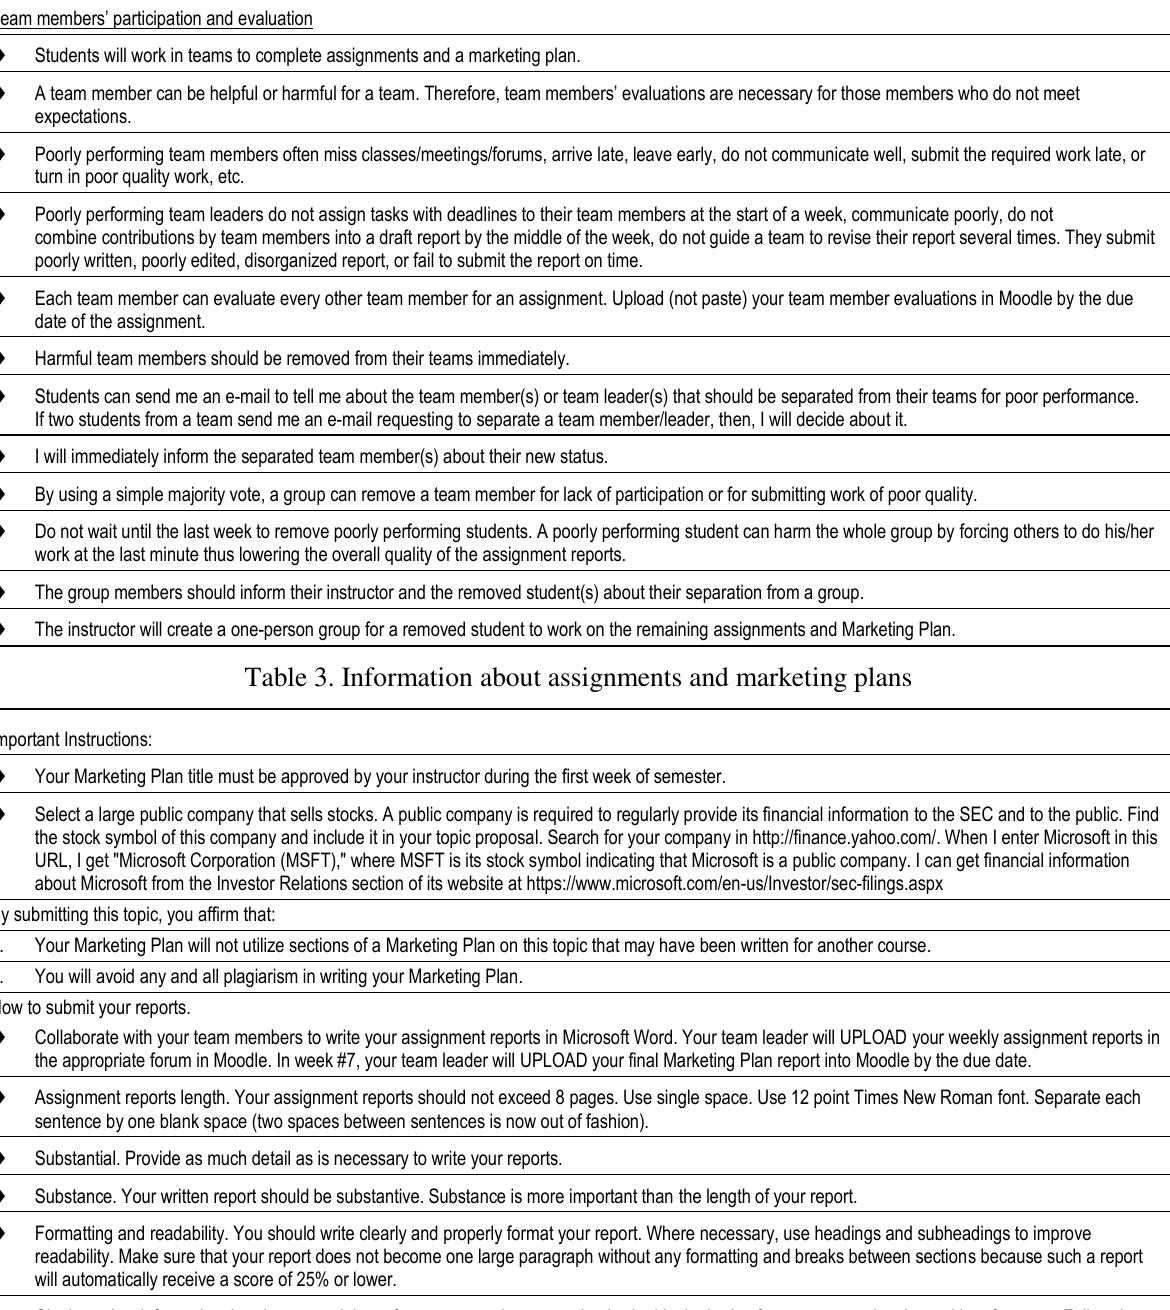
Table 2. Team member s’ participation and evaluation